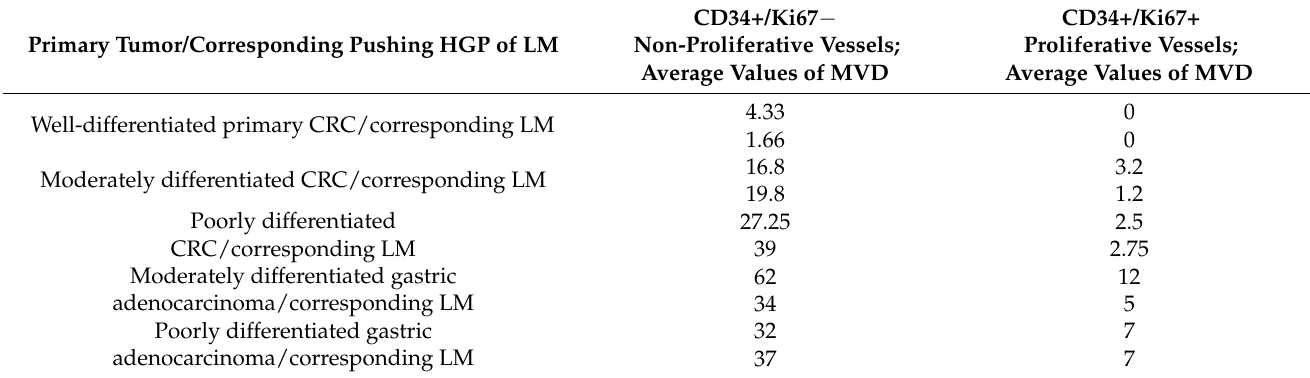
Table 1. Distribution of mean values of microvascular density in primary tumors and their corre- sponding LMs, with a p-HGP.